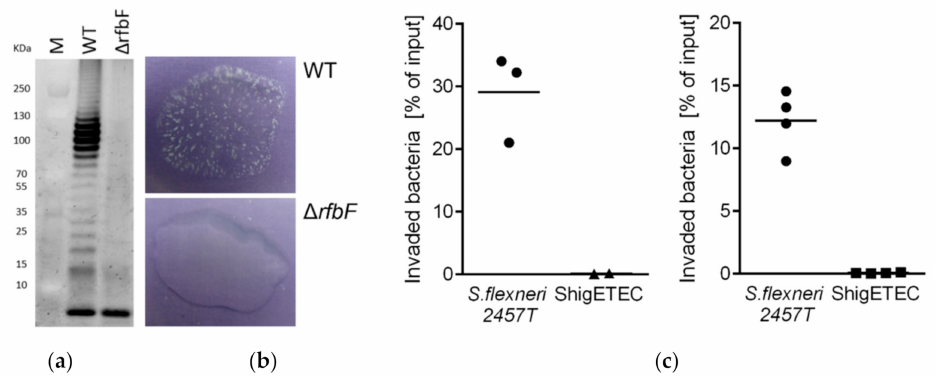
Figure 2. ( a ) SDS-PAGE gel image of separated LPS from Shigella flexneri 2457T wild-type (WT) and Shigella flexneri 2457T ∆ rfbF mutant following staining with Pro-Q ® Emerald 300 Lipopolysaccharide Gel Stain Kit. The lowest band represents the lipid A-core molecules, while the upper ladder-like pattern is the LPS molecule with various number of O-antigen repeating units. ( b ) Agglutination assay with Shigella flexneri 2457T wild-type (WT, top panel) and its isogenic ∆ rfbF mutant (bottom panel) using rabbit anti- Shigella flexneri 1–6 serum. ( c ) HeLa cells were infected with the wild-type parental Shigella flexneri 2a 2457T or ShigETEC at a MOI of 80. Percentage of intracellular (invaded) bacteria relative to the inoculum was determined by CFU calculations after plating. Data are shown from two independent experiments.